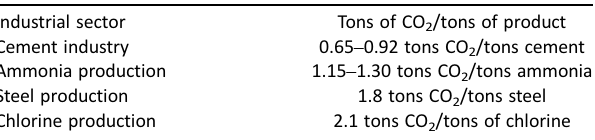
Table 1. Tons of CO 2 produced/tons of product refereed to dif- ferent industrial sectors [1 –